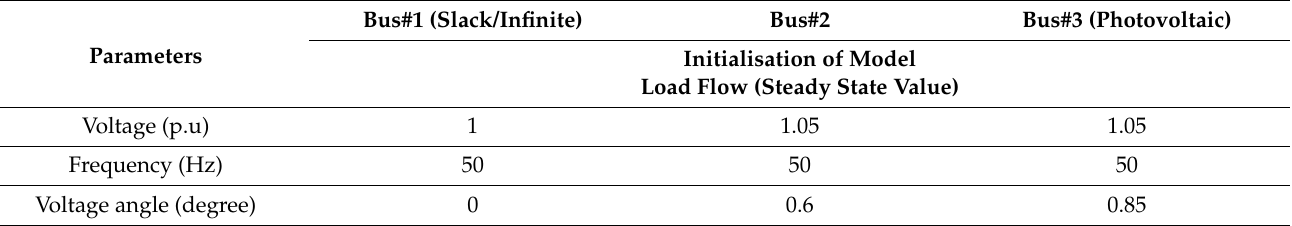
Table 4. Summary of Simulation